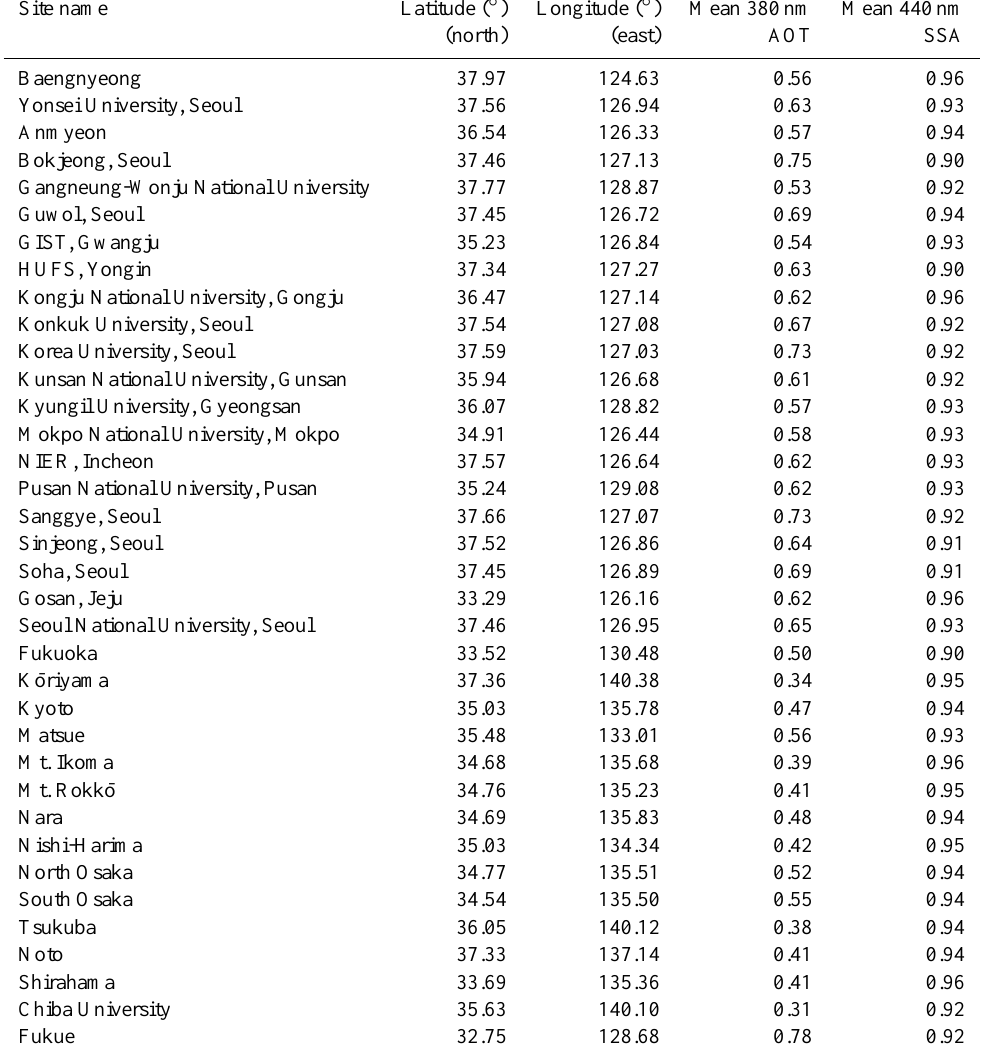
Table 1. Positions and mean AOT and SSA at 388nm of the AERONET sites during the DRAGON-NE Asia 2012 campaign.